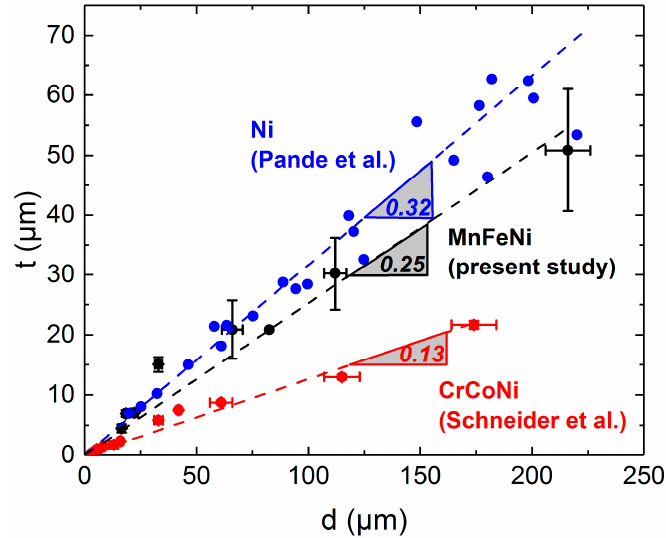
Figure 9. Average annealing twin thickness ( t ) as a function of the mean grain size ( d ). The black data points were obtained for MnFeNi in the present study, whereas the blue points were obtained from Pande et al. [42] for pure Ni and the red ones by Schneider et al. [21] for an equiatomic CrCoNi alloy.